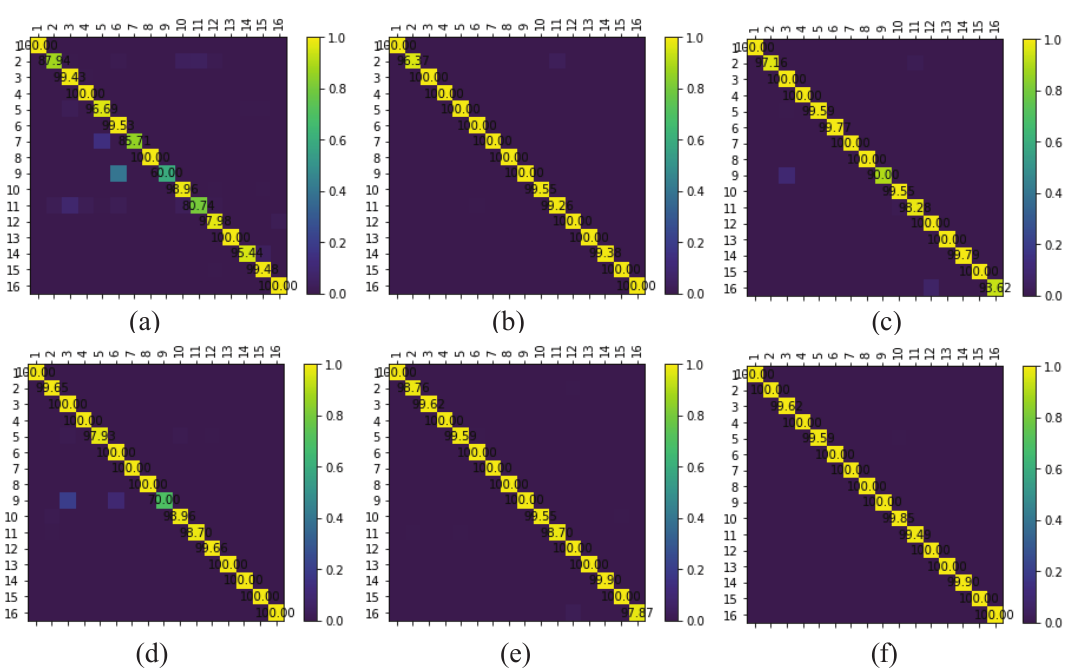
Figure 9. Normalized confusion matrices of classification results for the Indian Pines data set. ( a ) CNN.